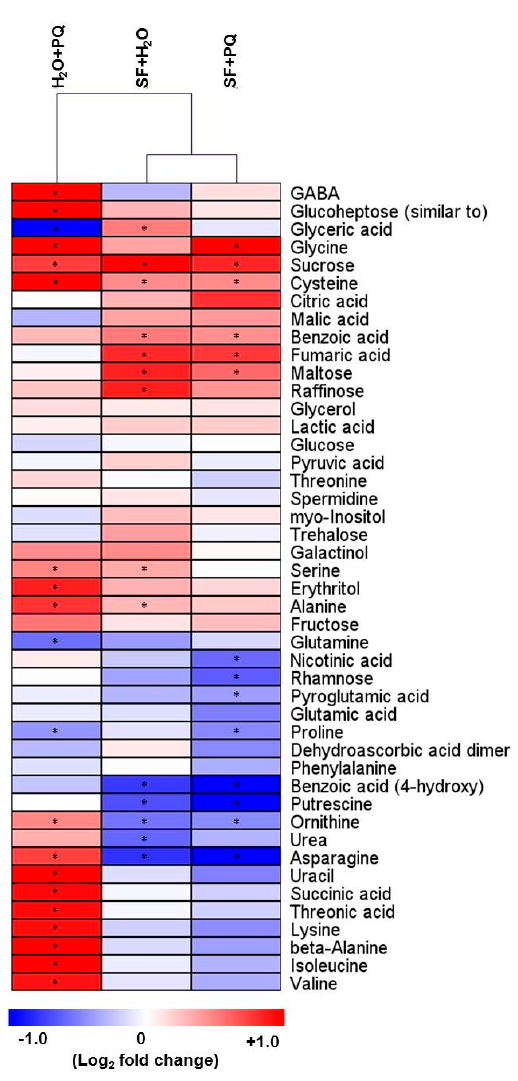
Figure 5. Primary metabolite changes induced by oxidative stress. Changes in primary metabolite abundances of Arabidopsis leaves upon foliar spray with PQ and/or SF measured by GC-MS. Blue and red depict a decrease and increase, respectively (log 2 fold change), compared to the control (unprimed and unstressed, i.e., H 2 O + H 2 O). The data are averages of seven biological replicates. Samples: PQ-stressed (H 2 O + PQ), SF-primed, but unstressed (SF + H 2 O), and SF-primed and stressed (SF + PQ). Statistically significant differences to control are highlighted by asterisks (Student’s t -test, * p -value < 0.05). Full data are given in Supplementary Materials Data S5.